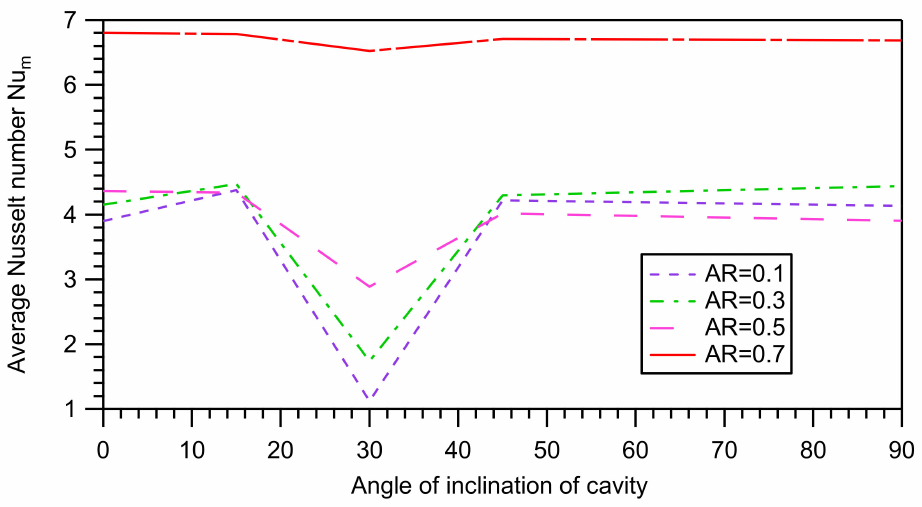
Figure 19. The average Nusselt number Nu m according to the angle of inclination of the cavity for di ff erent aspect ratios (AR = 0.1, 0.3, 0.5 and 0.7) with Ra = 10 5 , Da = 10 − 2 , ϕ = 0.04, Fr = 0.75, and q ∗ = 1.